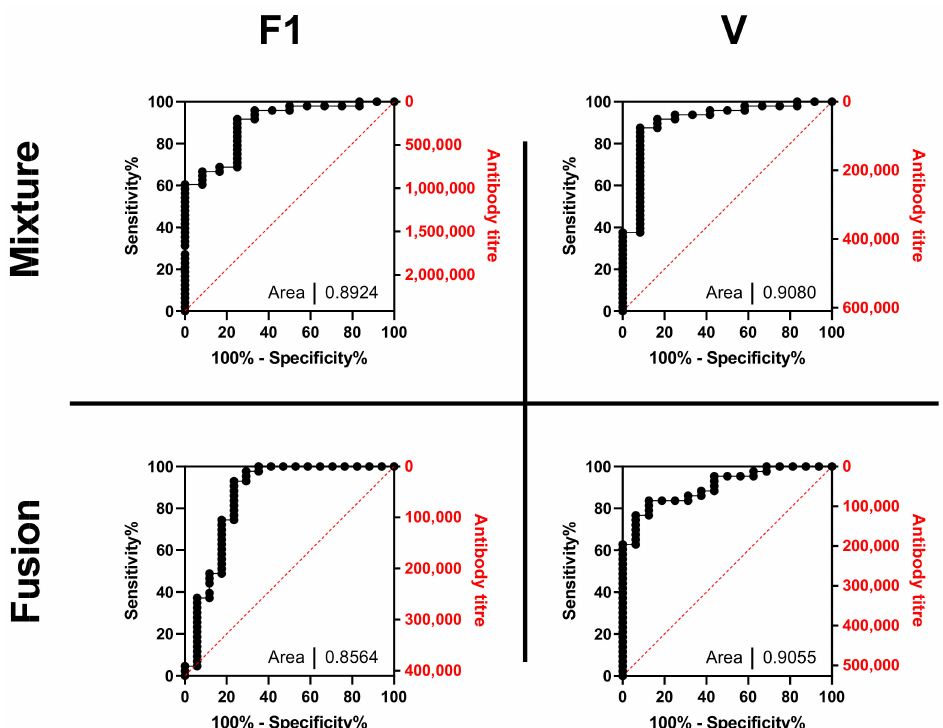
Figure 5. Receiver operator characteristic (ROC) curves of antibody titres in predicting survival after challenge with Y. pestis in immunised mice. These data include both titres specific to F1 (left) and V (right) and mice receiving a mixture of F1+V antigens (above) or the F1-V fusion protein (below). The ROC curves are shown in terms of titres (in ng/mL) and